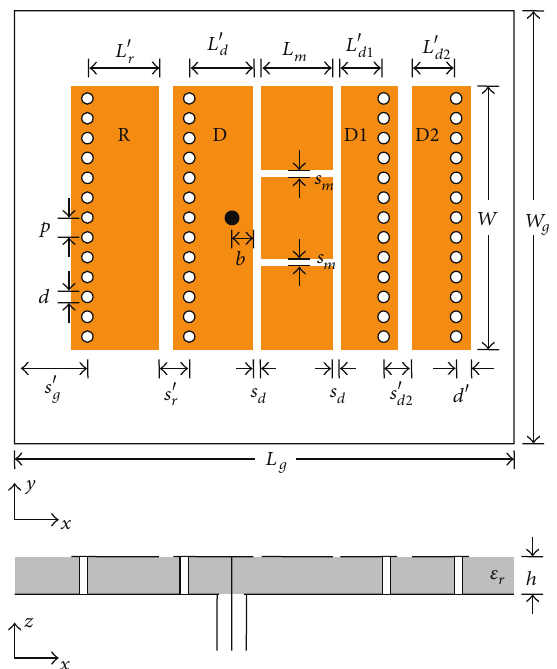
Figure 1: Top view and cross-section of the microstrip Yagi array of quarter-wave patch antennas.